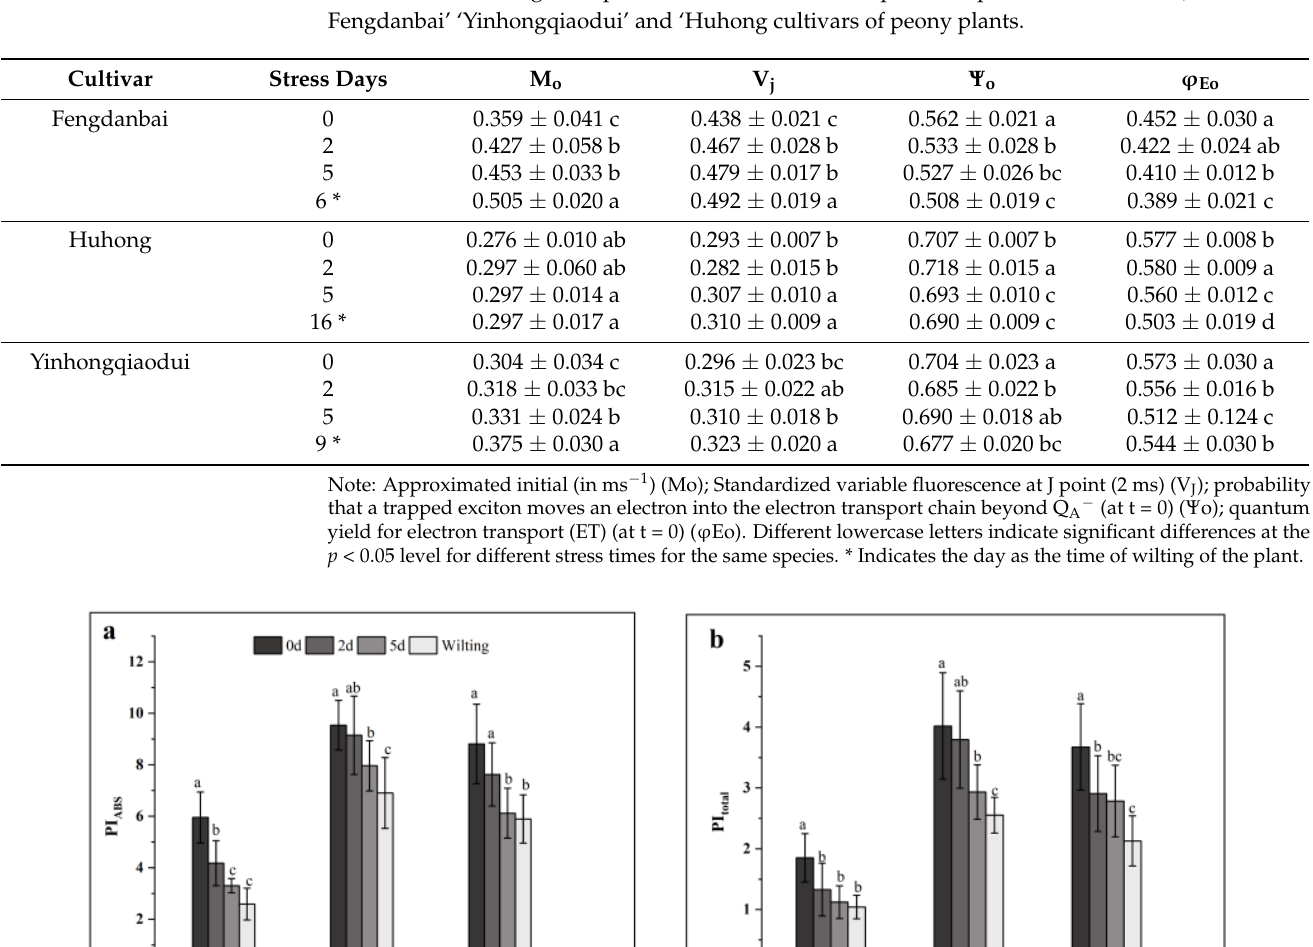
the varieties showed a decreasing trend compared to treatment at 0 h, with ‘Fengdanbai’ showing the largest percentage decrease of 28.16% compared to CK at 2 d of stress treatment. Table 5. Effects of high-temperature stress on PS II receptor-side parameters on the OJIP curves of